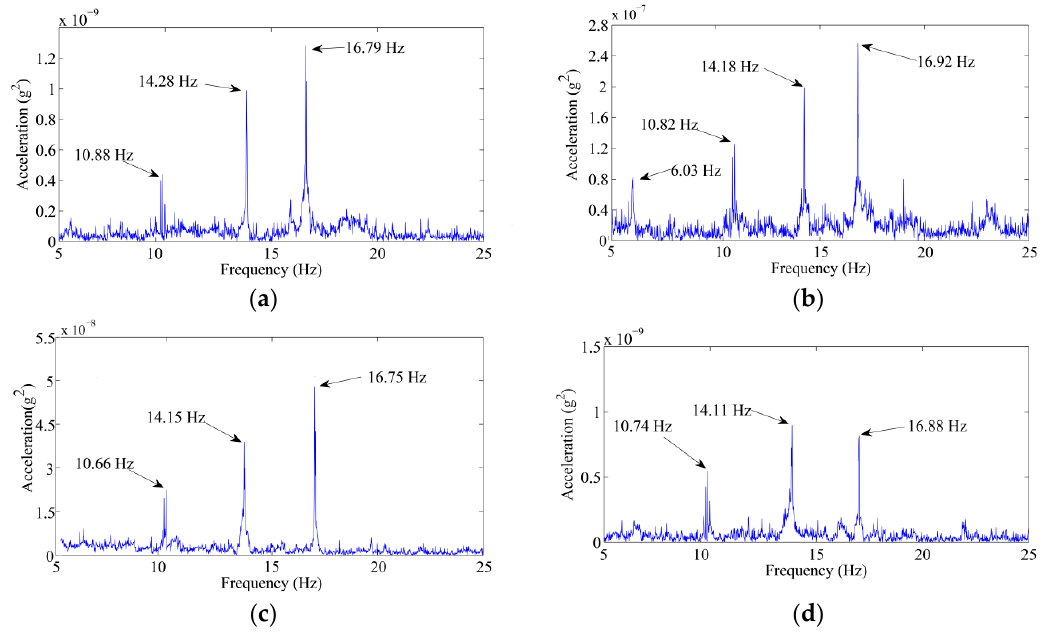
Figure 6. PSD of the sensors: ( a ) sensor 1; ( b ) sensor 2; ( c ) sensor 3; ( d ) sensor 4.